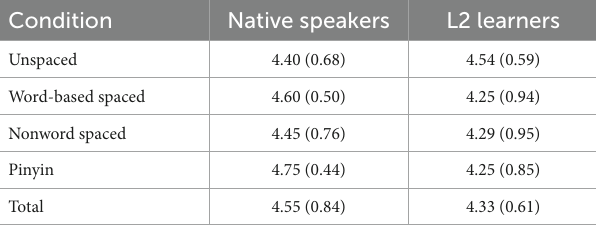
TABLE 3 Mean comprehension scores across the four presentation conditions (SD in